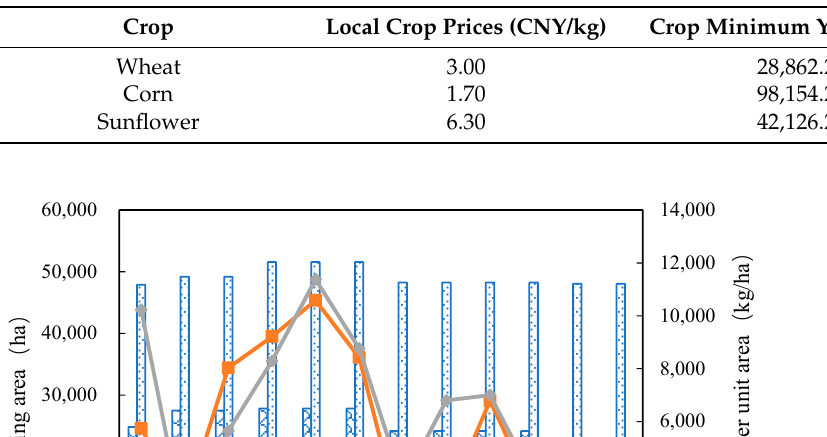
Table 4. Local price and minimum yield of crop.